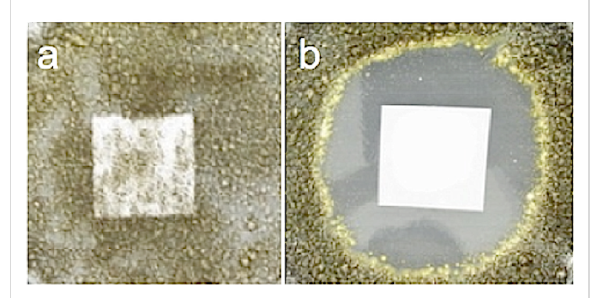
Figure 4: Growth of A. niger in the presence of (a) untreated paper and (b) paper with ZnO nanorods, after 72 h of growth.